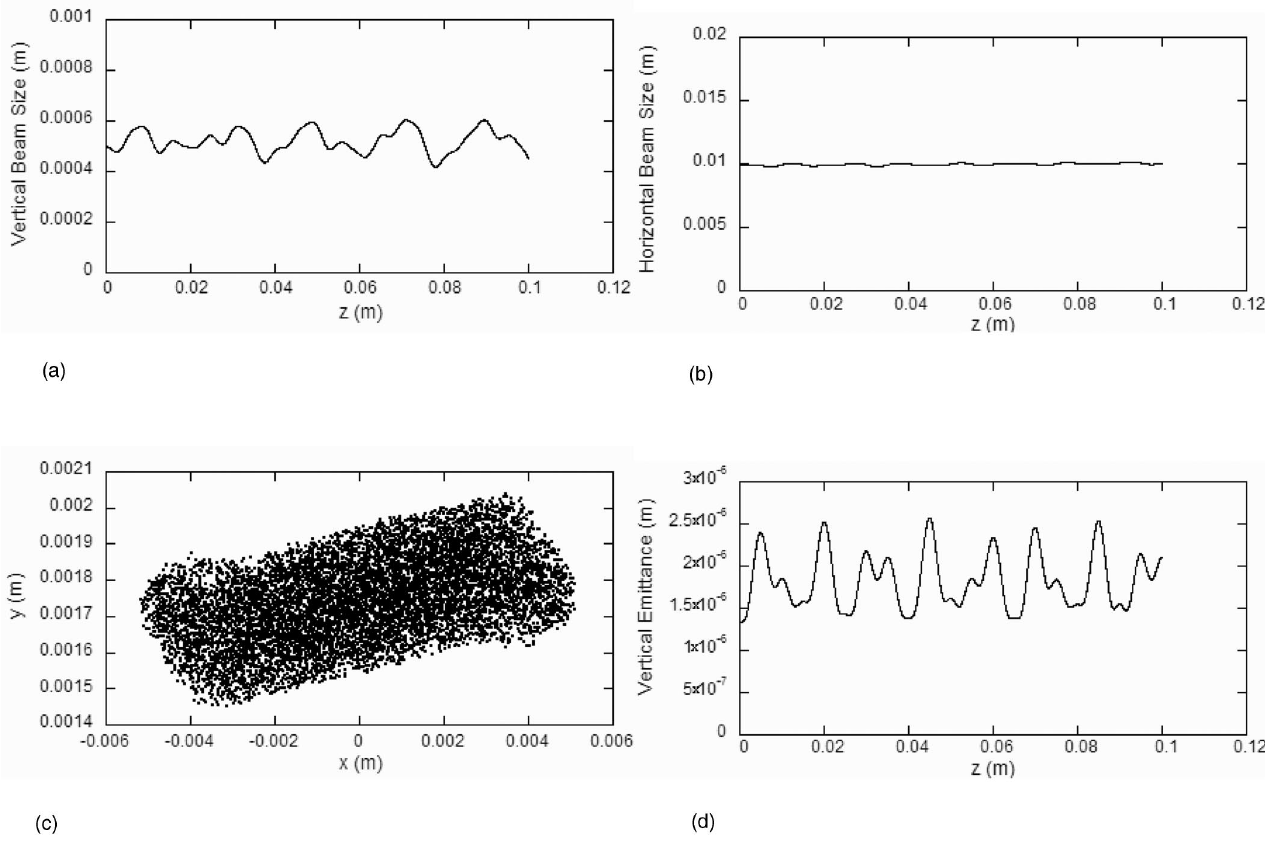
FIG. 8. Two-plane focusing case for PPM focusing with reduced horizontal space-charge force, with peak field of 0.295 Tand a wave number ratio of 0.14. (a) Vertical beam size versus axial position. (b) Horizontal beam size versus axial position. (c) Final x - y beam distribution. (d) Vertical emittance versus axial